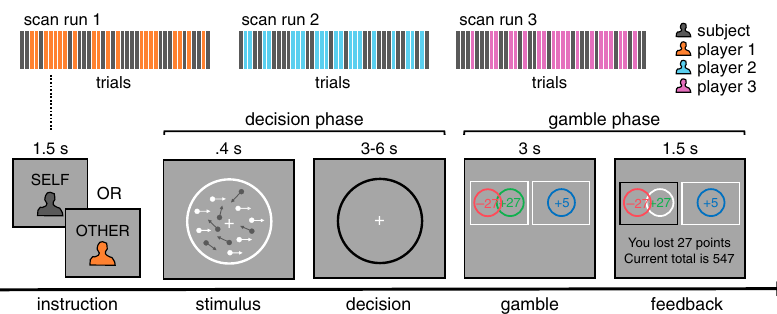
Fig. 1 Social random dot motion task. On each trial, participants placed a bet on a motion discrimination judgement (left or right) made by either themselves or one of three other players who varied in terms of their ability. The bet was made by choosing between a safe option, which yielded a small but guaranteed reward, and a risky option, which delivered a greater reward if the self- or other-choice was correct and a corresponding loss if incorrect. In this example, the participant chose the risky option (black box), but the self- or other-choice was incorrect. If participants chose the safe option, then they were informed what the outcome would have been had they selected the risky option. Participants were instructed how to calculate choice accuracy from the feedback screen. Participants were paired with the three other players in a block-wise manner, and the trial type was signalled at the start of a trial. For fMRI analysis, we refer to the time window from the onset of the motion stimulus to 3 s after the onset of the decision screen as the decision phase and the time window from the onset of the gamble screen to the offset of the feedback screen as the